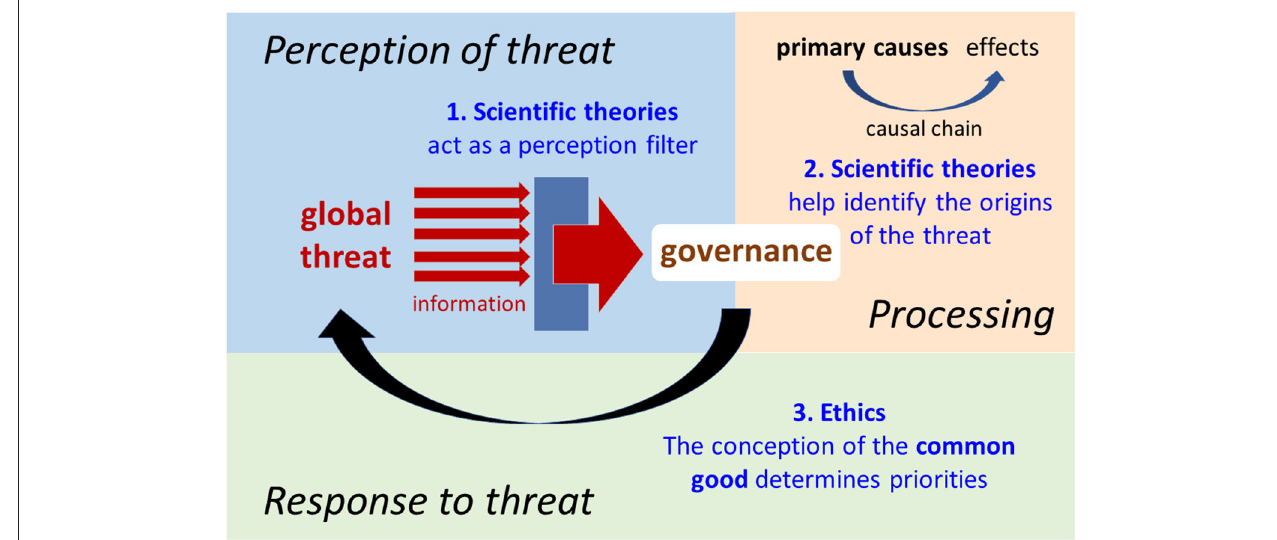
FIGURE 2 | Schematic view of the decision-making process in the face of global threats.